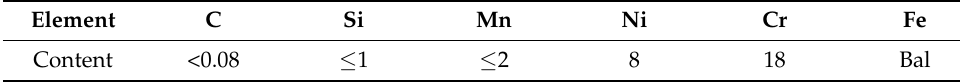
Table 1. Composition of 304 steel strip (mass fraction,